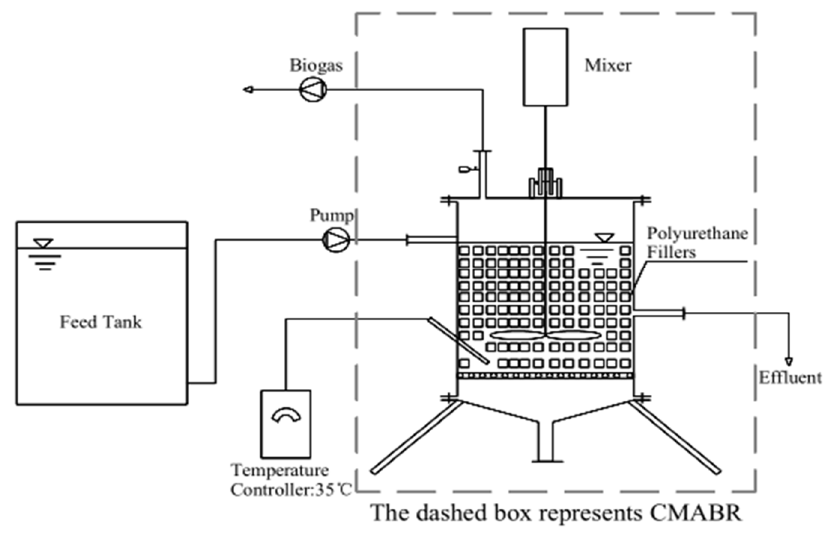
Figure 1. Reactor configuration. Table 1. Box–Behnken experimental design and the corresponding responses.